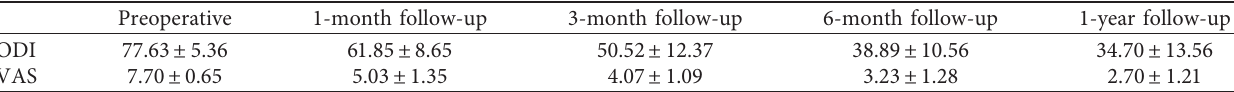
Table 2: Clinical outcome assessment.